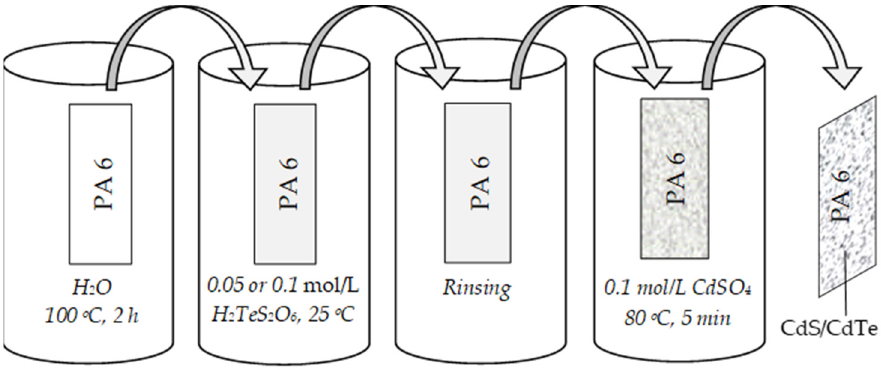
Figure 1. Schematics of cadmium chalcogenide layer formation procedure.